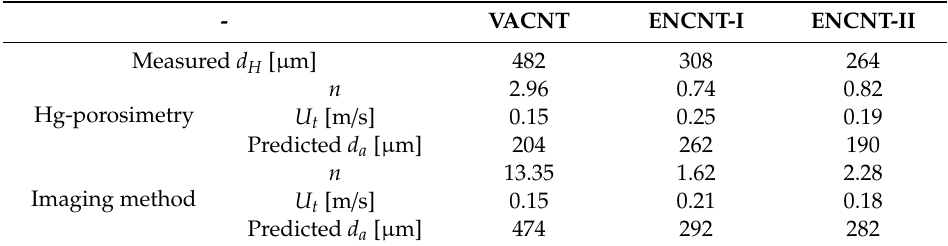
Table 2. Comparison of predicted sizes of CNTs by imaging and Hg-porosimetry